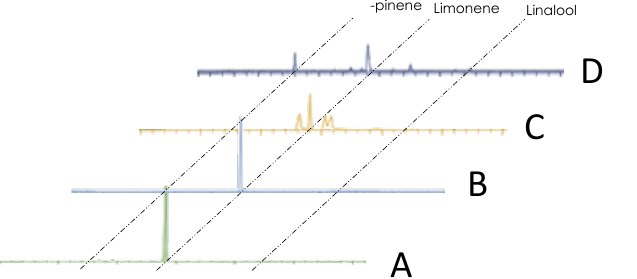
Figure 3. Volatile component chromatograms of citrus essential oils from A = peel of ‘Sai-Namphaung’ tangerine; B = peel of ‘Fremont’ mandarin; C = commercial citrus oil; D = fruit of makhwaen.